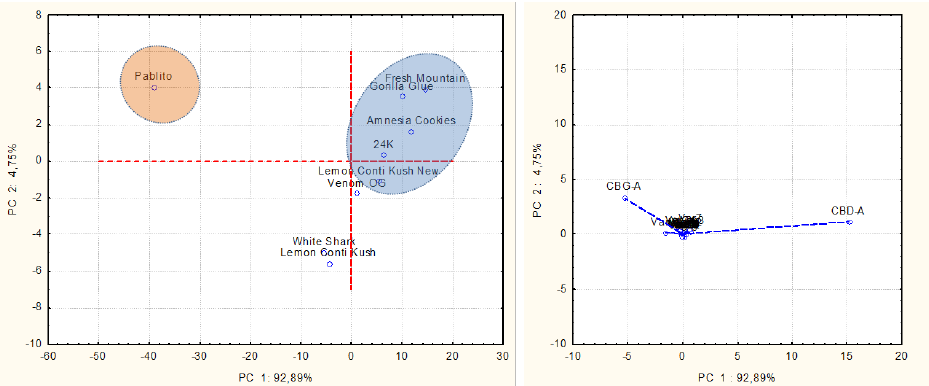
Figure 5. Representation of PCA score and loading plots reporting hemp varieties and their contents of terpenes, polyphenols, and cannabinoids.